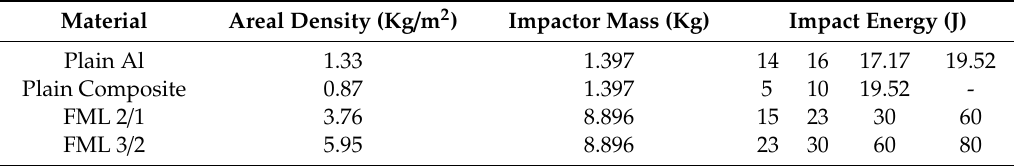
Table 2. Impact energy evaluated for each investigated